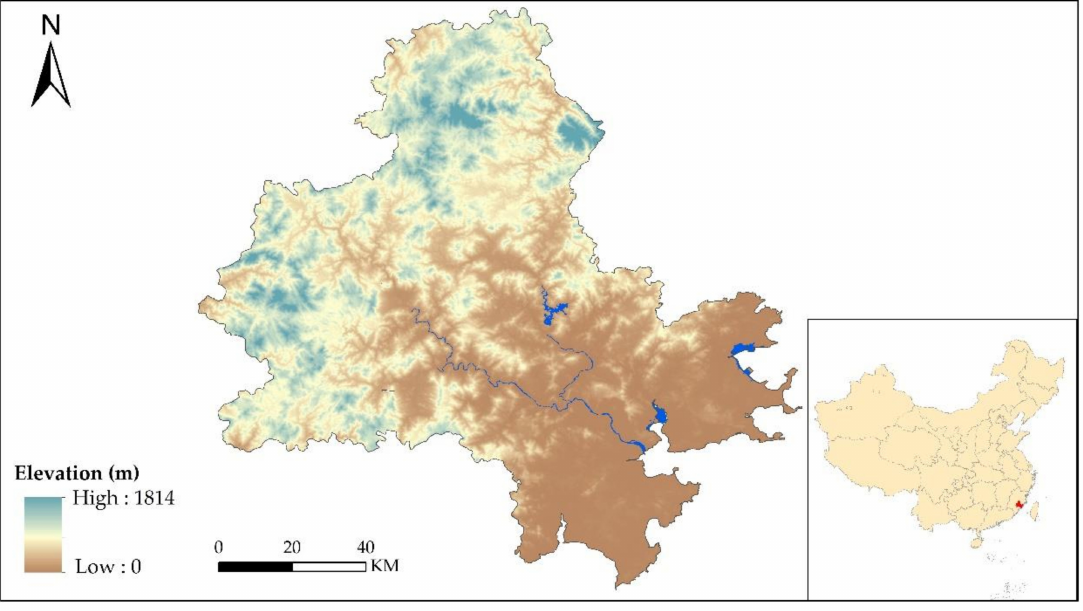
Figure 1. Location of